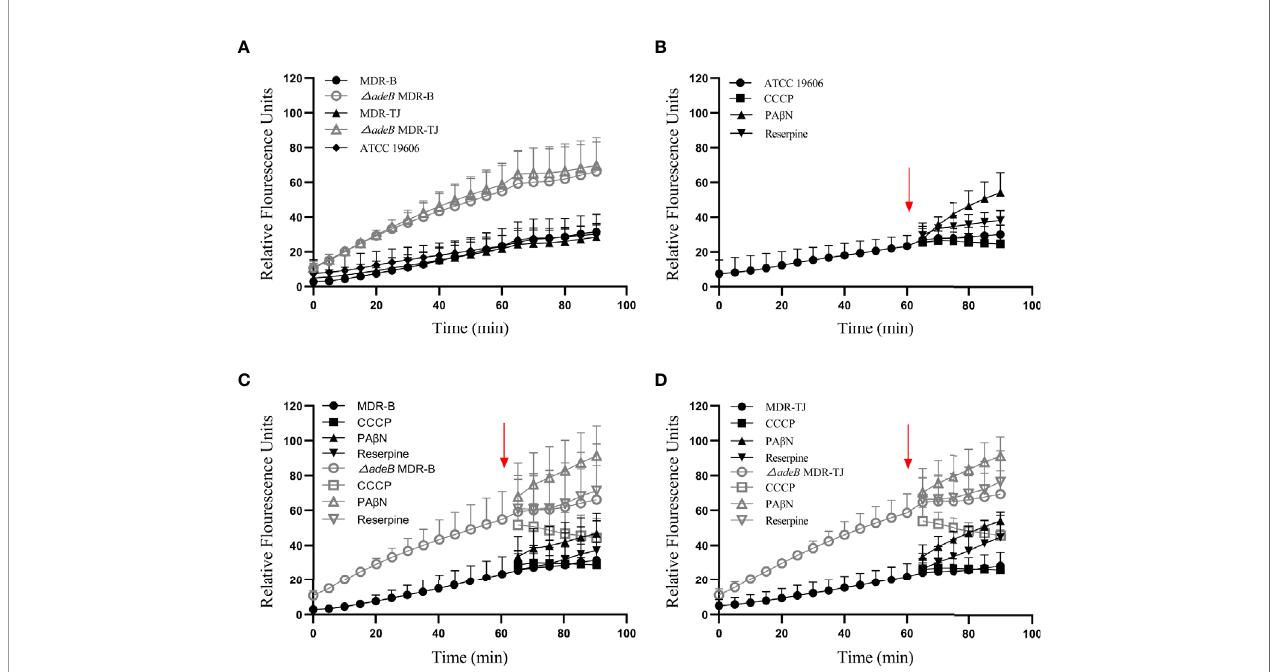
FIGURE 5 | BBH accumulation in A. baumannii strains. The amount of BBH was determined as relative fl uorescence units. (A) BBH uptake by A. baumannii strains in 90 min. BBH uptake with pump inhibitors CCCP, PA b N, and reserpine in (B) ATCC 19606 strain, (C) MDR-B and △ adeB MDR-B strains, and (D) MDR-TJ and △ adeB MDR-TJ strains. Red arrows indicate the pump inhibitors (50 µM) were added at 60 min. Grey letters indicate the inhibitors were added to the adeB knockout strains.